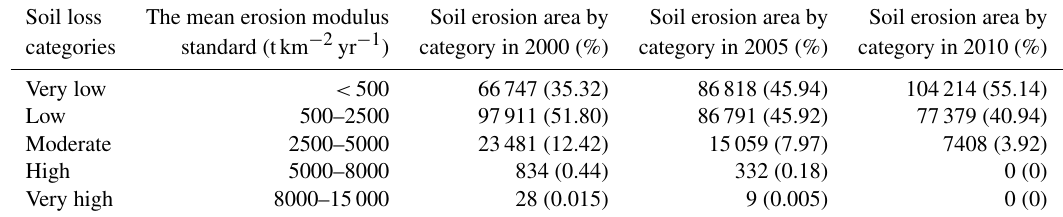
Table 2. Areas of different categories of soil loss in the study catchment (ha). Soil loss The mean erosion modulus Soil erosion area